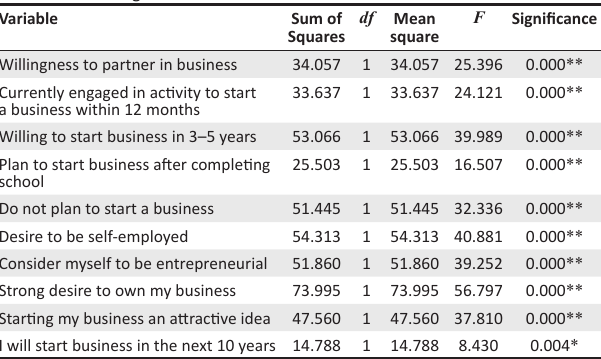
TABLE 3: Analysis of variance test on motivation versus starting a business in the absence of social grant income. Variable Sum of